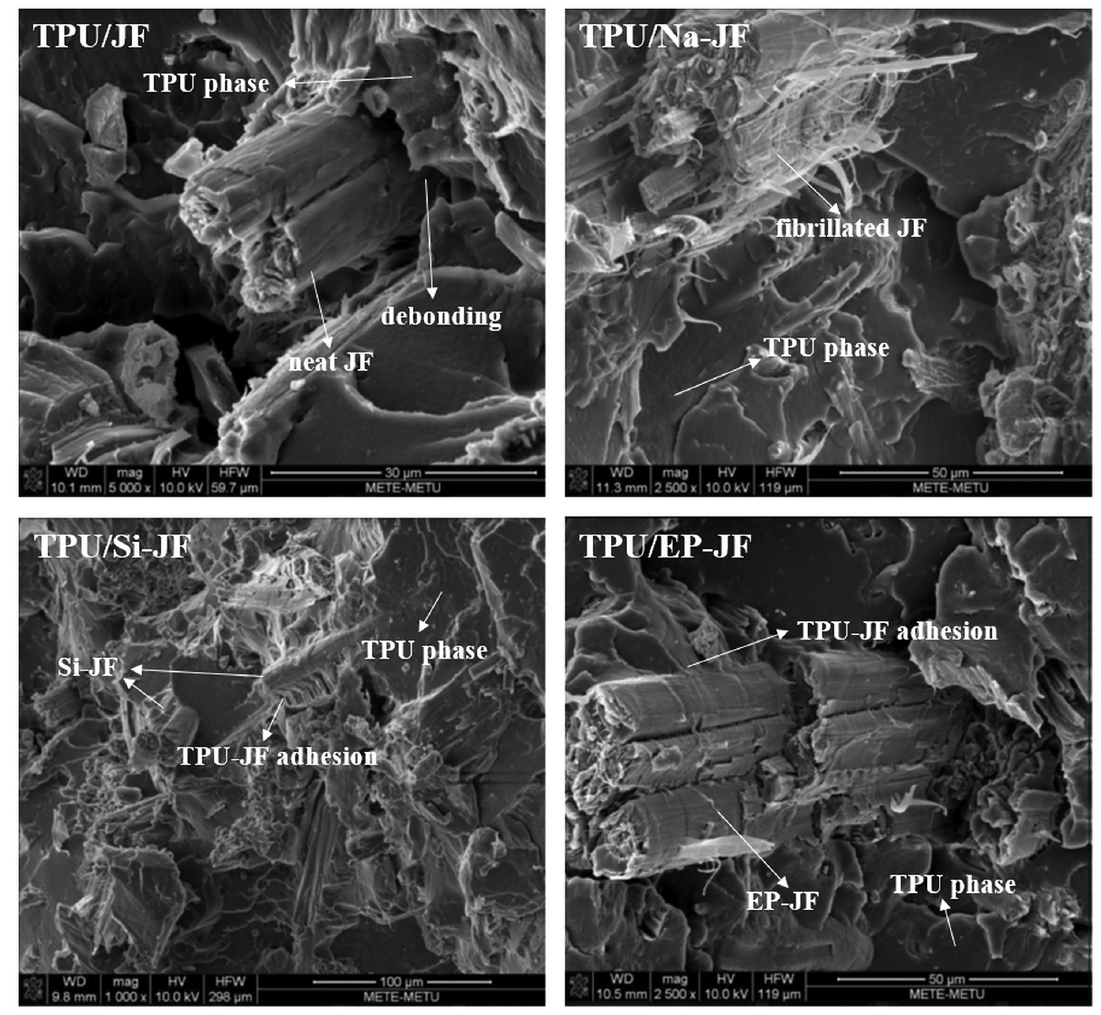
Figure 7: SEM micro-images of